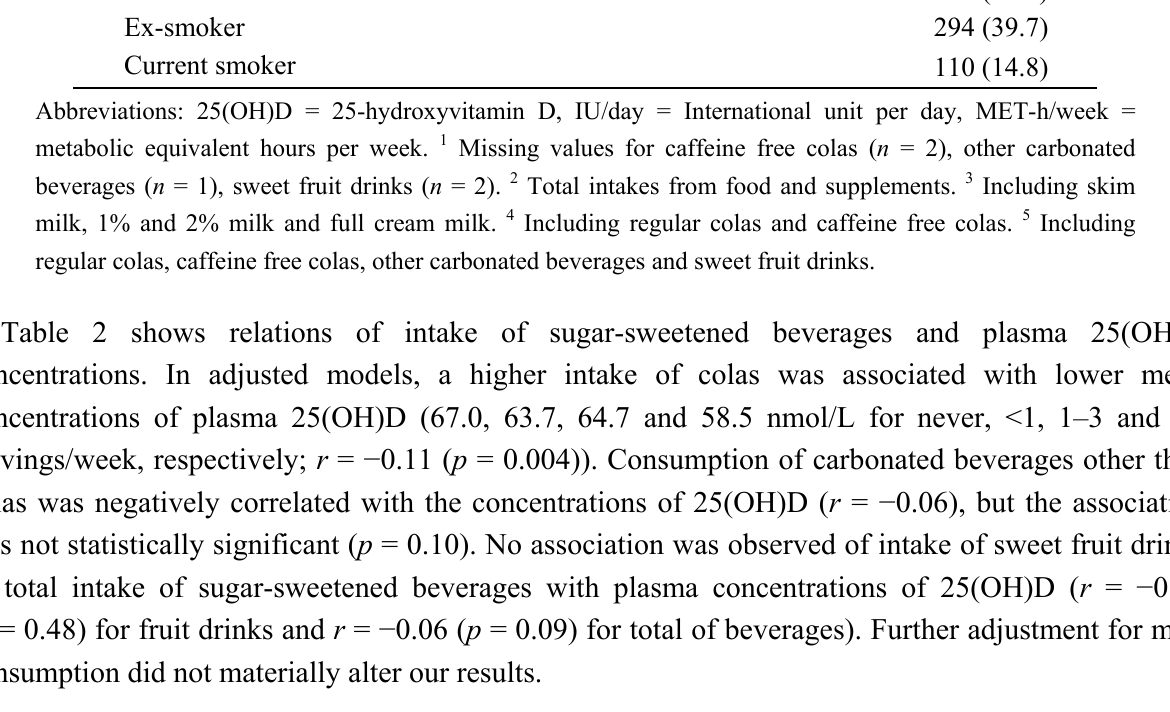
Relations of intake